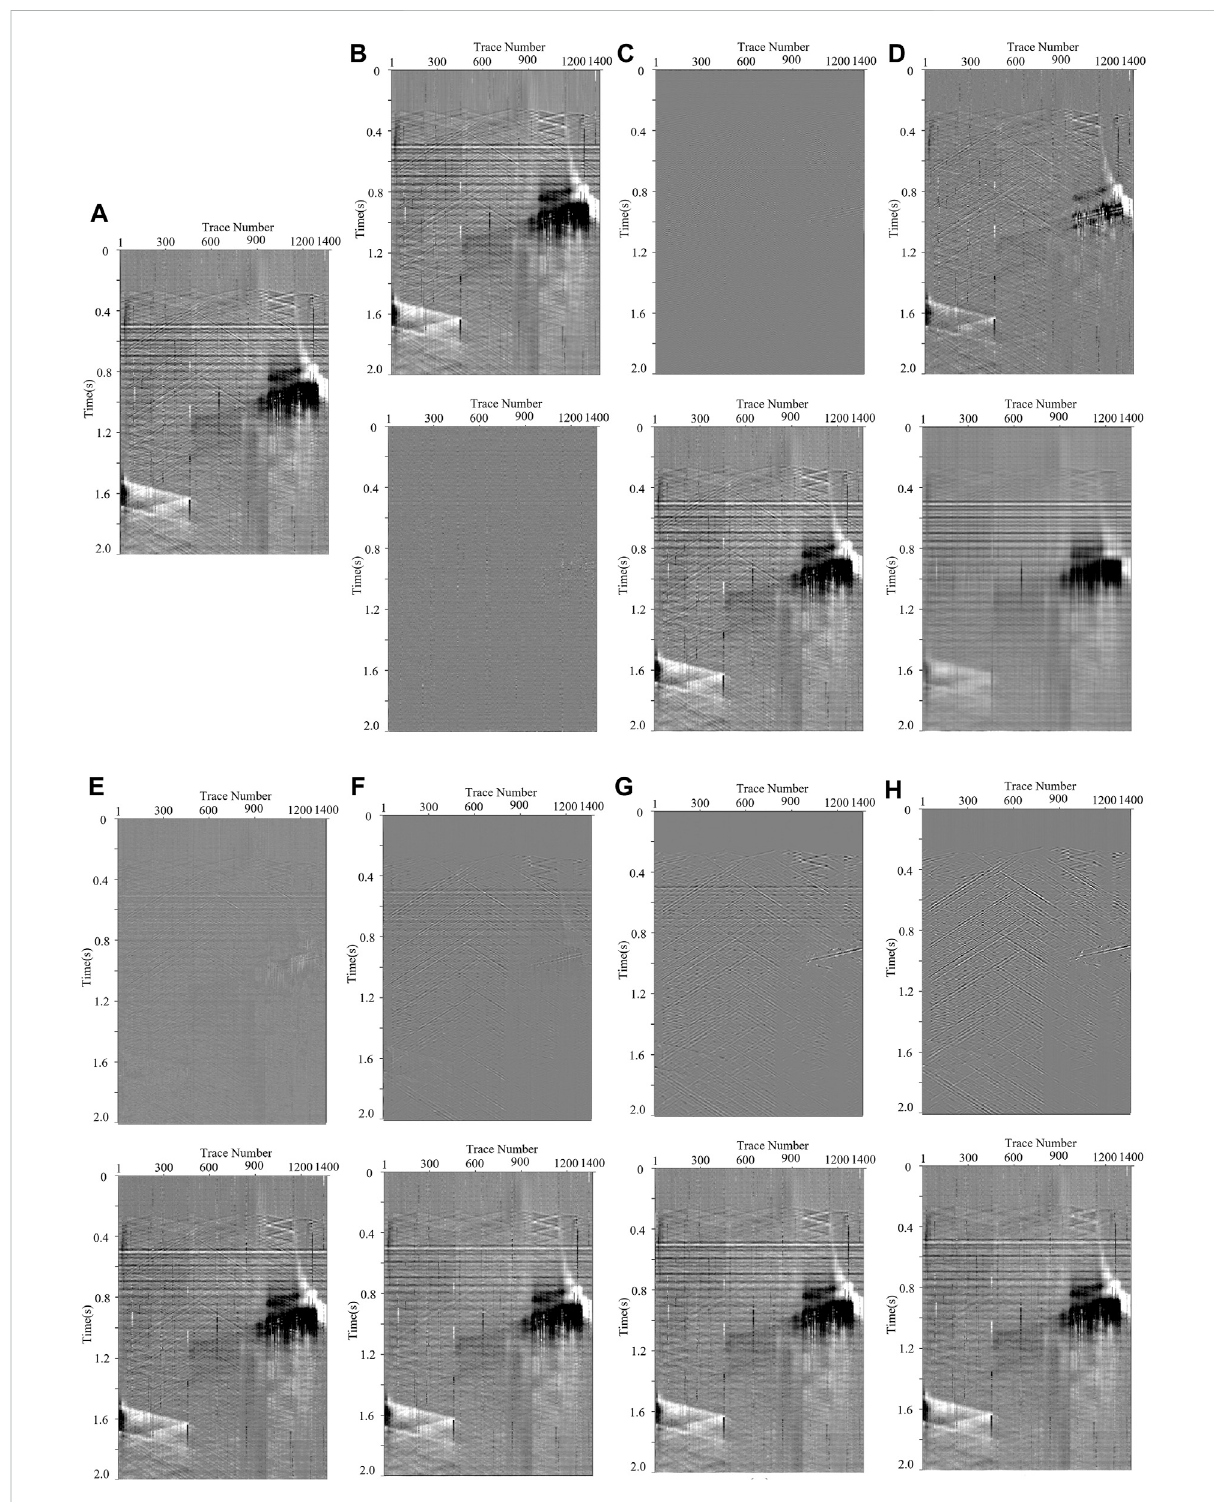
FIGURE 9 The denoising results for another fi eld DAS-VSP record: (A) is the fi eld DAS data, and (B – H) are the attenuation results after TFPF, BPF, RPCA, DnCNN, U-Net, RED-Net and MDD-Net, respectively.